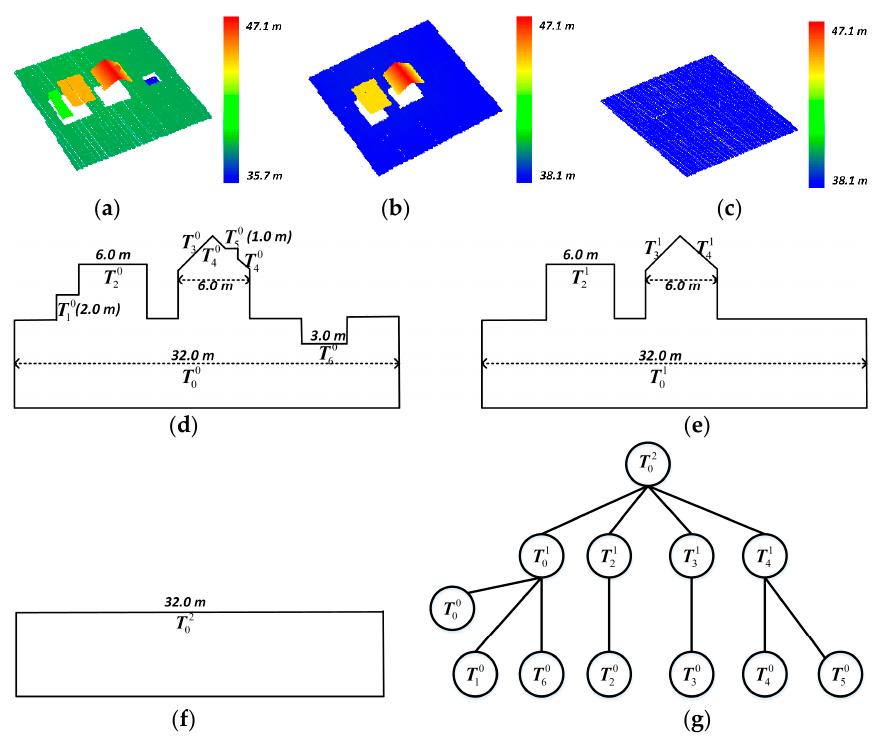
Figure 2. Generation of scale-space and the topological relationship graph within a building. ( a – c ) Results of morphological reconstruction at the first scale ( (cid:1871) = 0 m ), the second scale ( (cid:1871) = 2 m ) and the third scale ( (cid:1871) = 4 m ); ( d – f ) Results of scale space are displayed by cross-sections, and the location of the cross plane is illustrated in Figure 1a; ( g ) Topological relationship graph, which is generated by relinking the relationship between two segments from adjacent